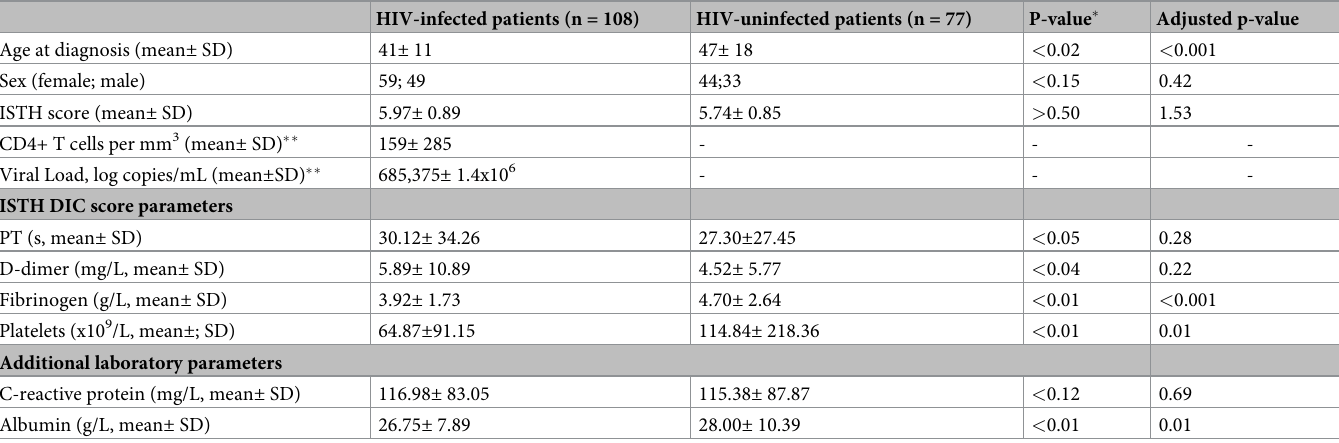
Table 2. Demographic and laboratory parameters in patients presenting with a